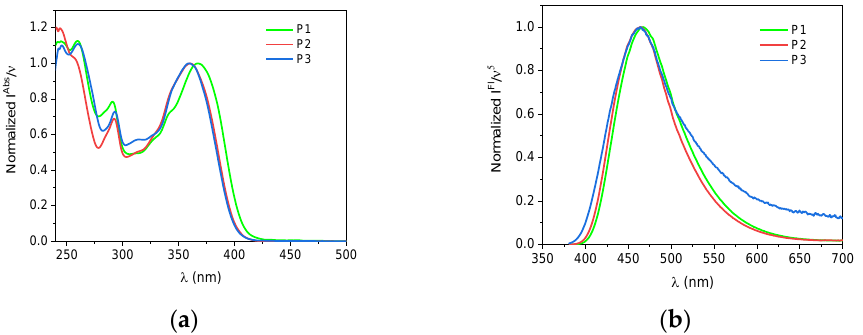
Figure 1. Scaled and normalized, steady-state absorption (left panel, a ) and fluorescence (right panel, b ) spectra of the studied compounds in CHCl 3 .